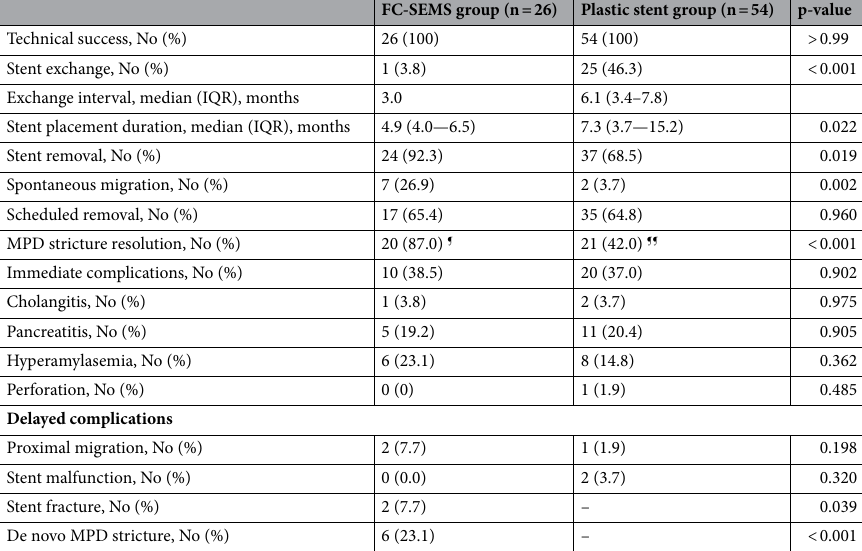
Table 2. Comparison of procedure-related outcomes. ¶ Excluding 3 patients without follow-up pancreatography after stent removal. ¶¶ Excluding 4 patients without follow-up pancreatography after stent removal. Abbreviations: FC-SEMS, fully covered self-expandable metal stent; IQR, interquartile range; MPD, main pancreatic duct.